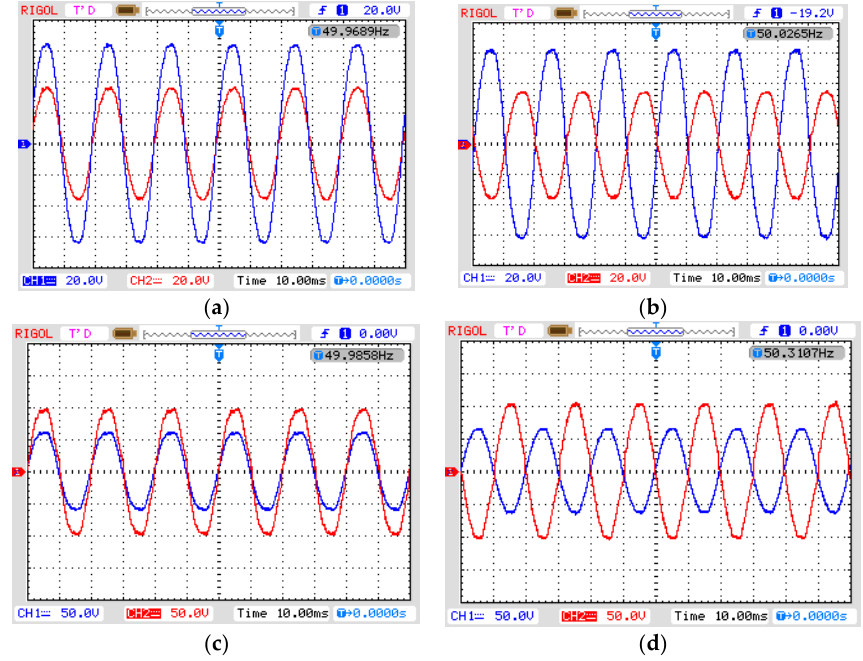
Figure 10. Input (blue) and output (red) voltage ( a ) non-inverting buck mode; ( b ) inverting buck mode; ( c ) non-inverting boost mode; ( d ) inverting boost mode.